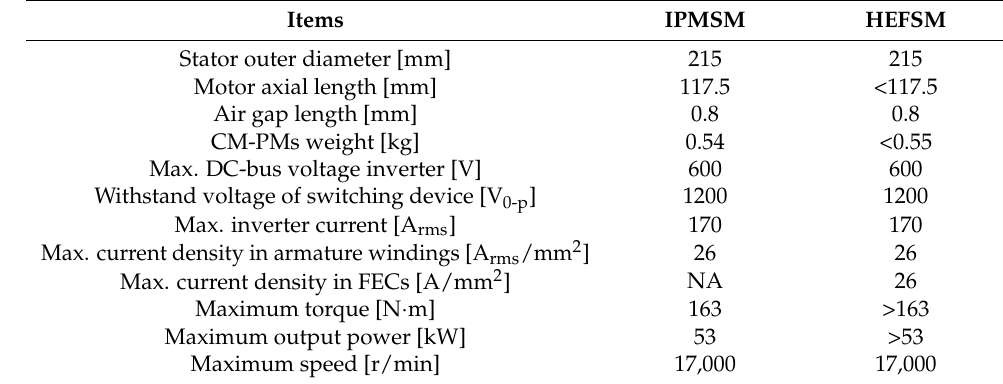
table are determined with reference to the specifications of the IPMSM. The total motor axial length including the end-coil length, stator outer diameter, airgap length, and total weight of CM-PMs used are limited or fixed as shown in the table. Electrical limitations and thermal restrictions are also set as follows, assuming that the same inverter and the same cooling system as the target IPMSM drive system are applied, respectively [15]. The target drive performances, such as the maximum speed, power, and torque are set to 17,000 r/min, 53 kW, and 163 Nm, respectively. Table 1. Design constraints and target performances. ©2020 IEEE. Reprinted with permission, from K. Otsuka, T. Okada, T. Mifune, H. Matsumori, T. Kosaka and N. Matsui, Proceeding of 2020 IEEE Energy Conversion Congress and Exposition (ECCE), IEEE,